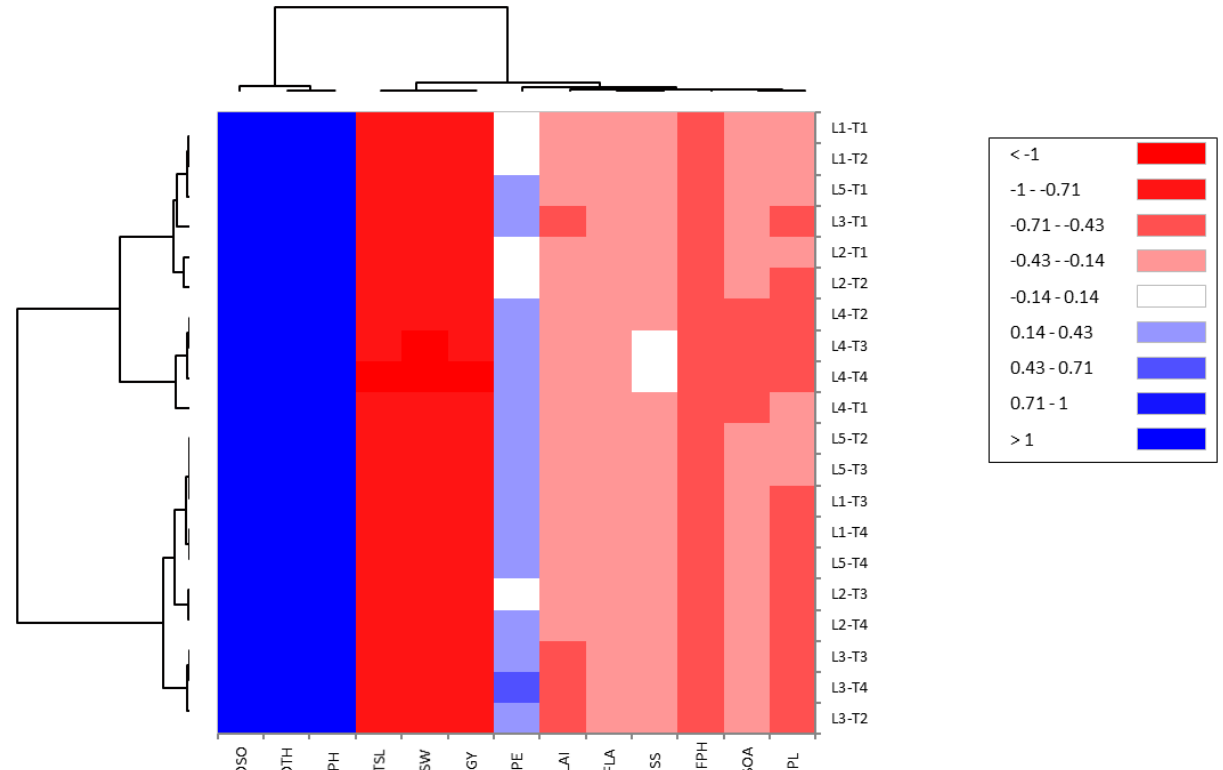
Figure 3. Correlation heatmap of the evaluated traits of CMS lines under cyanobacteria treatment conditions.